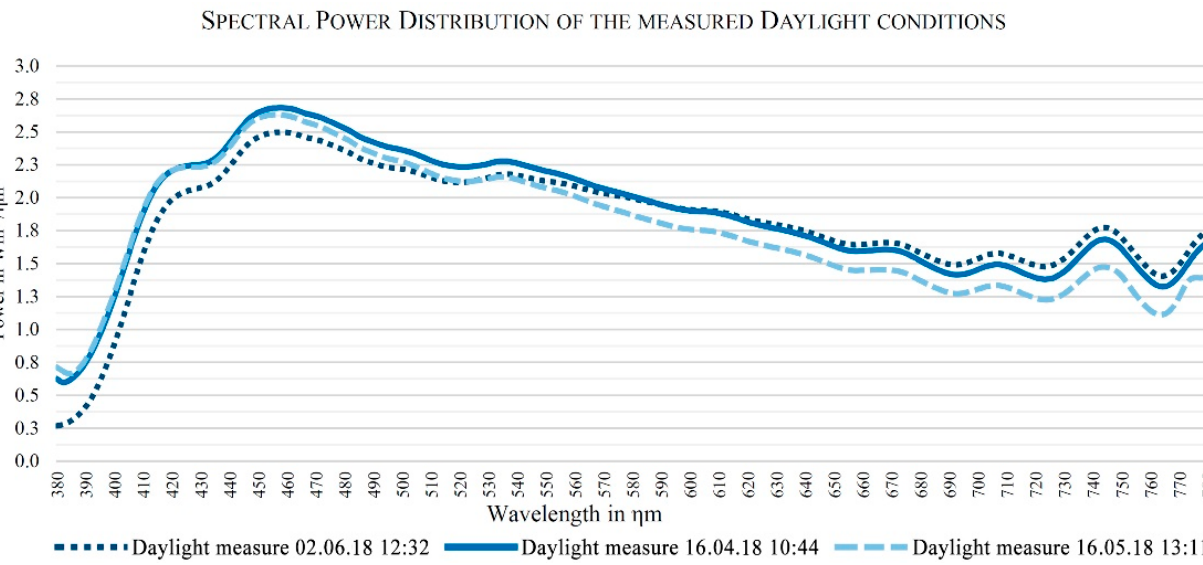
Figure 4. SPD of the daylight conditions perceived inside the testing box.